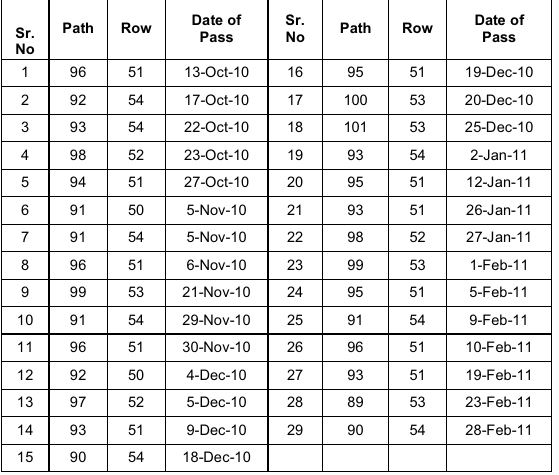
Fig. 1: Study States selected for the study (Rajasthan, Haryana,